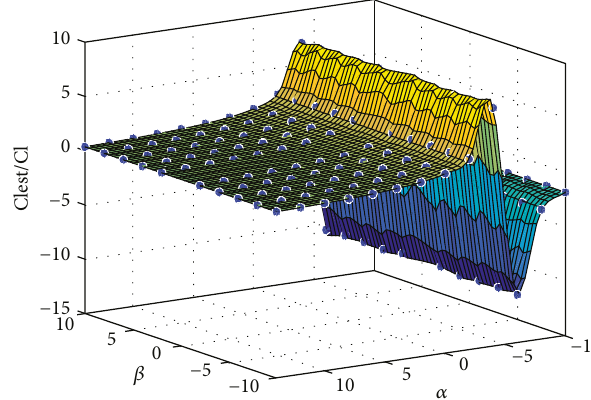
Figure 6: The ratio between estimated rolling moment (Clest) and total rolling moment (Cl).